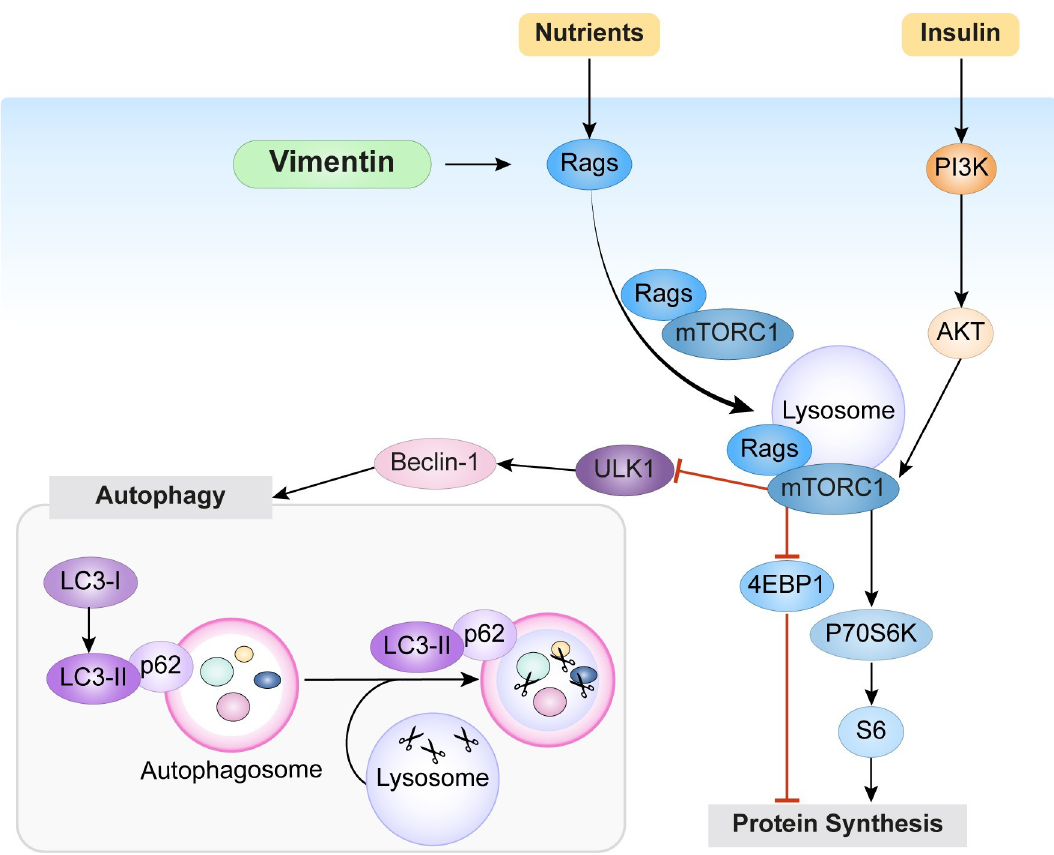
Fig 7. Vimentin regulates mTORC1 signaling by facilitating mTORC1 localization to lysosomes. A simplified scheme of the mTORC1 signaling system. Our results demonstrate that in the presence of nutrients, vimentin facilitates mTORC1 activation by regulating Rag GTPase activation. This results in the phosphorylation of 4EBP1 and P70S6K downstream targets, which lead to protein synthesis. Moreover, activation of mTORC1 results in decreased autophagy, as demonstrated by higher levels of the autophagic flux indicator p62 and reduced LC3I conversion to LC3II. As this autophagy inhibition works even under nutrient- starved condition, in the absence of AKT activation, the results imply that vimentin inhibits autophagy by mTORC1-mediated inhibition of ULK1-Beclin pathway. In this way, vimentin promotes cell size in 2 directions: by boosting protein synthesis through mTORC1 activation and by inhibiting of protein degradation through inhibition of autophagic flux. mTORC1, mechanistic target of rapamycin kinase complex